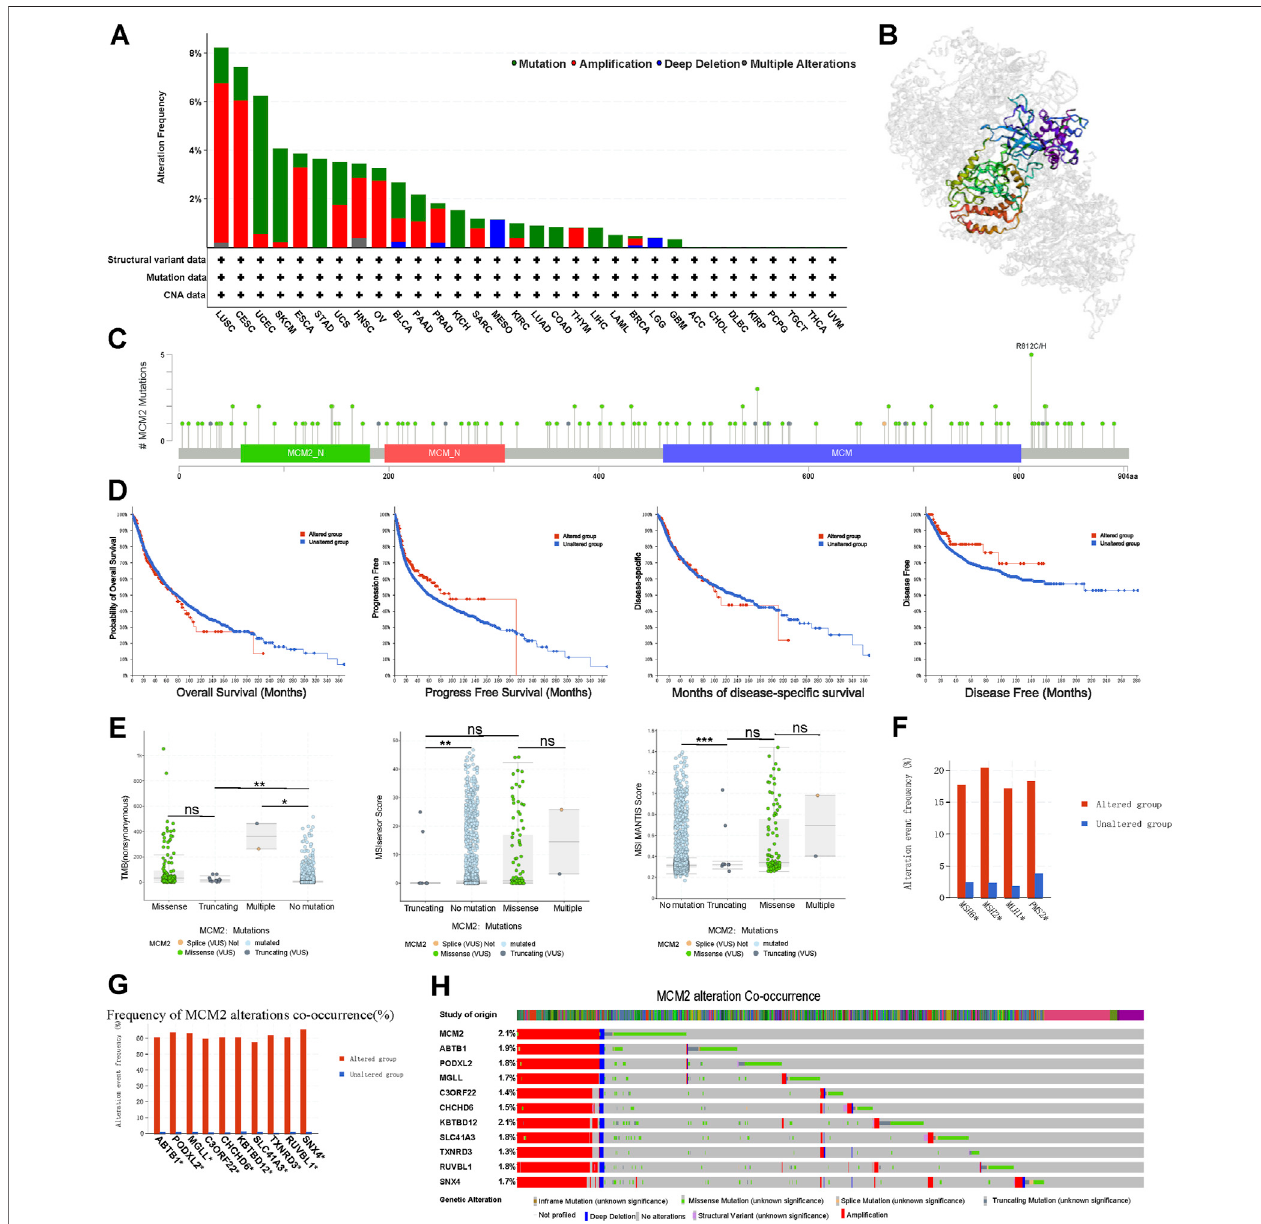
FIGURE5| MCM2genealterationsinvariouscancers. (A) MCM2genemutationtypeanalysisinvariouscancersbycBioPortal. (B) 3Dproteinstructure ofMCM2. Colored part means the binding region, while grey means the other part of MCM2. (C) The subtypes and distributions of MCM2 somatic mutations. X -axis, amino acids site; Y -axis, number of MCM2 mutations; green dot, missense mutations; grey dot, truncating mutations. (D) The correlation between mutation status and patient prognosis for all TCGA cancers, including overall survival, progression-free survival, disease-speci fi c survival and disease-free survival, analyzed using the cBioPortal tool. Red square indicated the MCM2 alteration group, Blue square indicated non-alteration group. (E) TMB and MSIsensor scores and MSI MANTIS scores in MCM2 nonmutant cancer and different subtypes of MCM2 mutant cancer (including truncating, missense and multiple). Each dot represents one patient. The black line represents the median and the interquartile ranges. X axes indicated different mutation type of MCM2. Y axes indicated scores of cases. (F) The mutant frequencies of MSH6, MSH2, MLH1 and PMS2 in the MCM2 mutant and nonmutant groups. (G) Bar plot showing the frequencies of the ABTB1, PODXL2, MGLL, C3ORF22, CHCHD6,KBTBD12,SLC41A3,TXNRD3, RUVBL1 and SNX4 alterations co-occurring withMCM2 alterations. (H) Waterfallplot showing the cooccurrence patterns of MCM2 alterations with the genetic alterations of ABTB1, PODXL2, MGLL, C3ORF22, CHCHD6, KBTBD12, SLC41A3, TXNRD3, RUVBL1 and SNX4. Color indicated the different mutation type of the 11 genes in